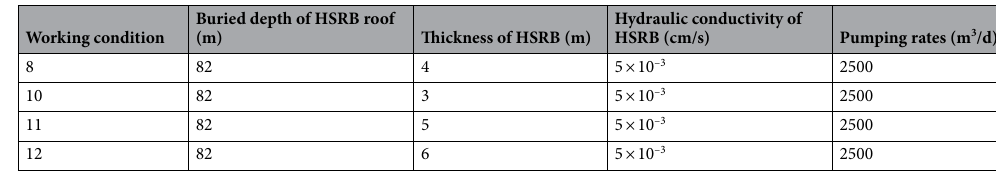
Table 6. Working conditions of different HSRB thicknesses.